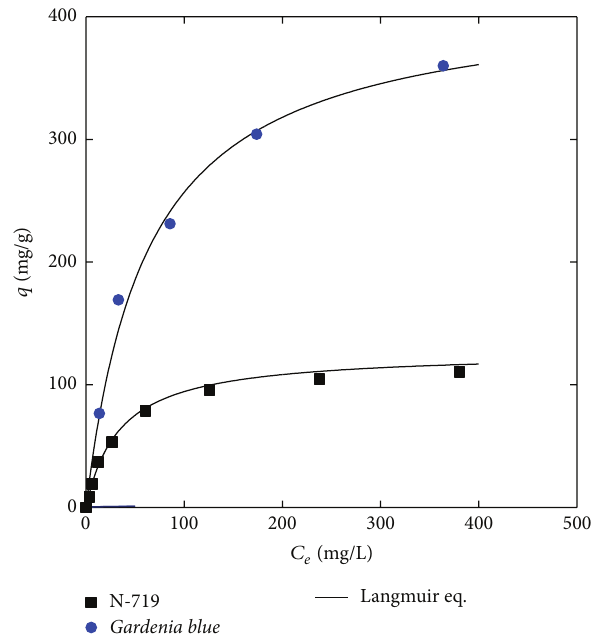
Figure 2: Adsorption equilibrium isotherms of Gardenia blue and N-719 on TiO 2 thin film at 298 K.